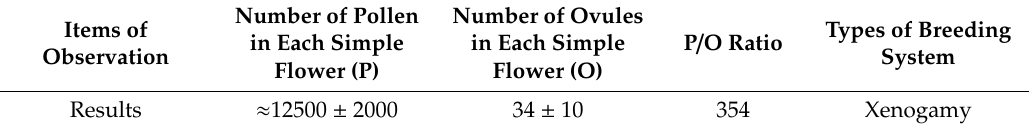
Table 1. Pollen to ovule (P / O) ratio of Sonneratia ×